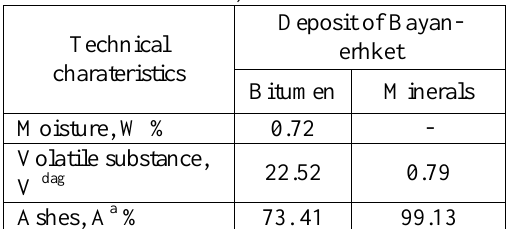
Table 2. Main technical characteristics of Bituminous sand, mass.%